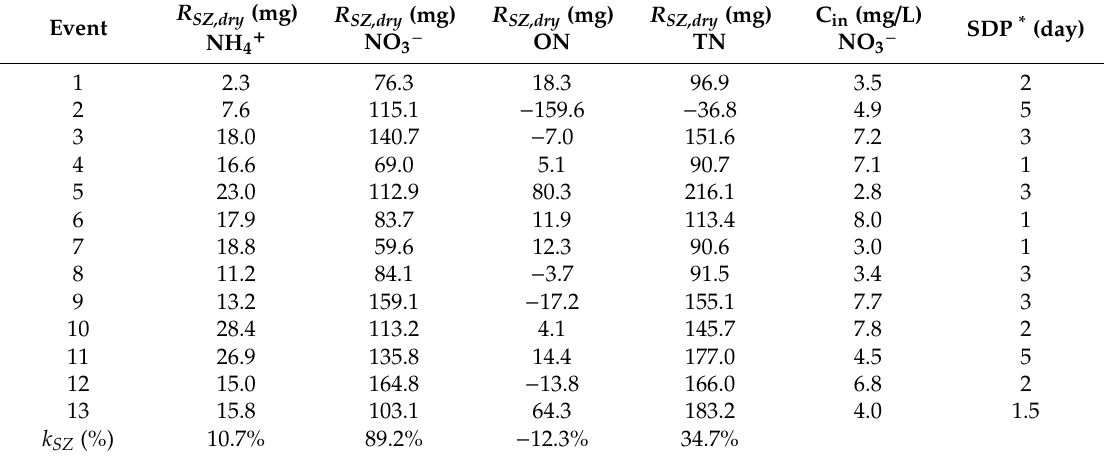
Table A3. Contribution of SZ during dry periods to various nitrogen species removal.